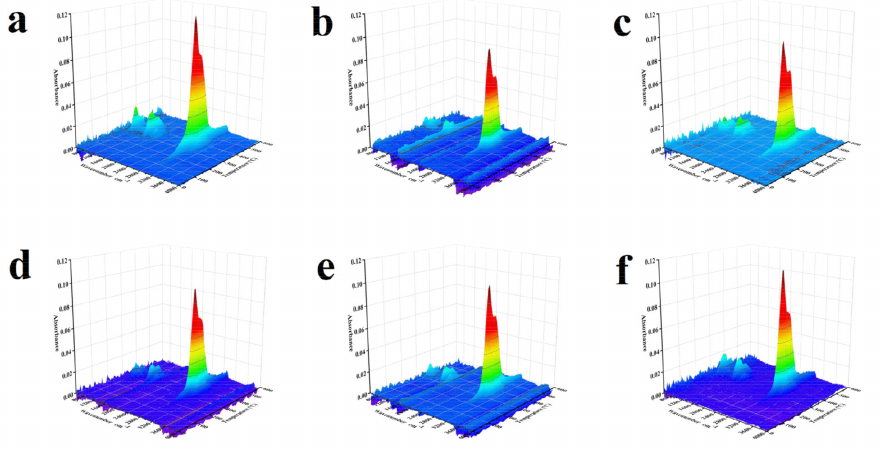
Figure 5. 3D FTIR spectra of the released volatiles from waste tire catalytic pyrolysis ( a ) No catalyst; ( b ) 10Ni; ( c ) 7Ni/3Fe; ( d ) 5Ni/5Fe; ( e ) 3Ni/7Fe; ( f )